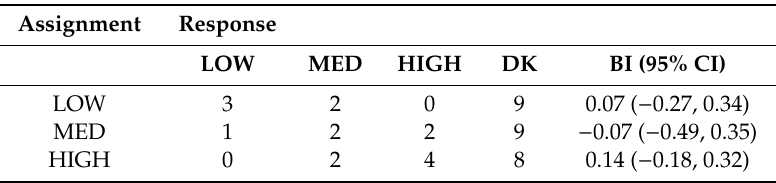
Table 2. Assessment of trial